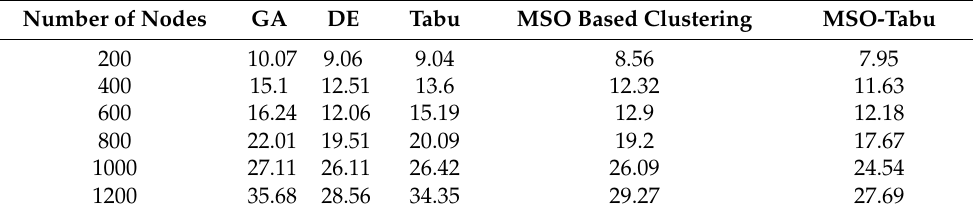
Table 4. Average packet loss rate for MSO-Tabu.